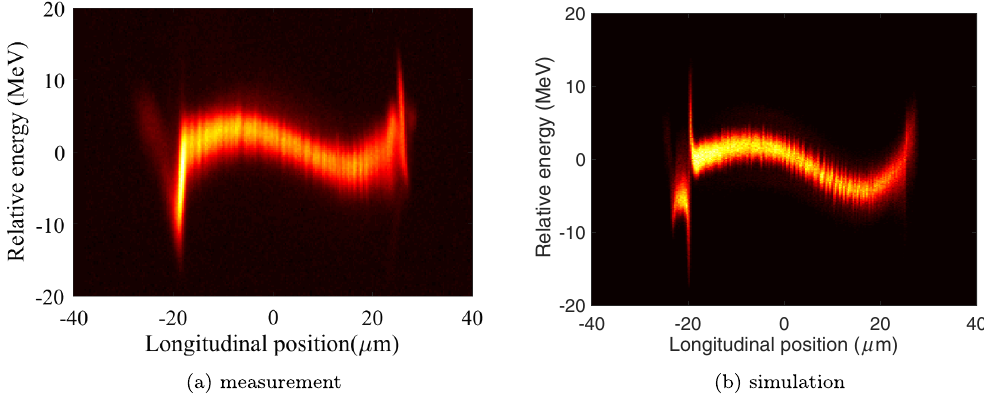
FIG. 7. Measurement (left) and simulation (right) of the final longitudinal phase space distribution with the laser heater at 19 keV. Beam current is 1 kA, with bunch charge 180 pC. The bunch head is to the right.